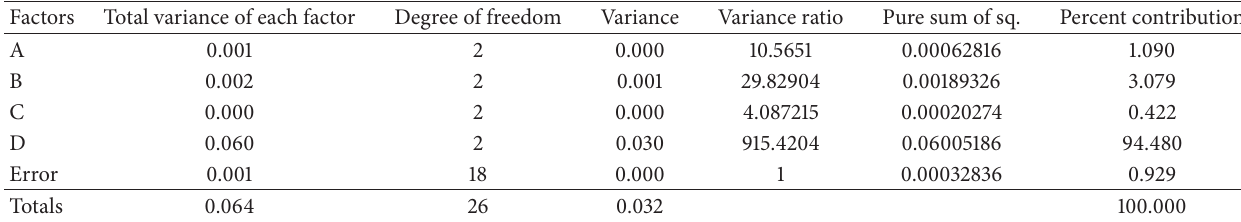
Table 4: ANOVA table.